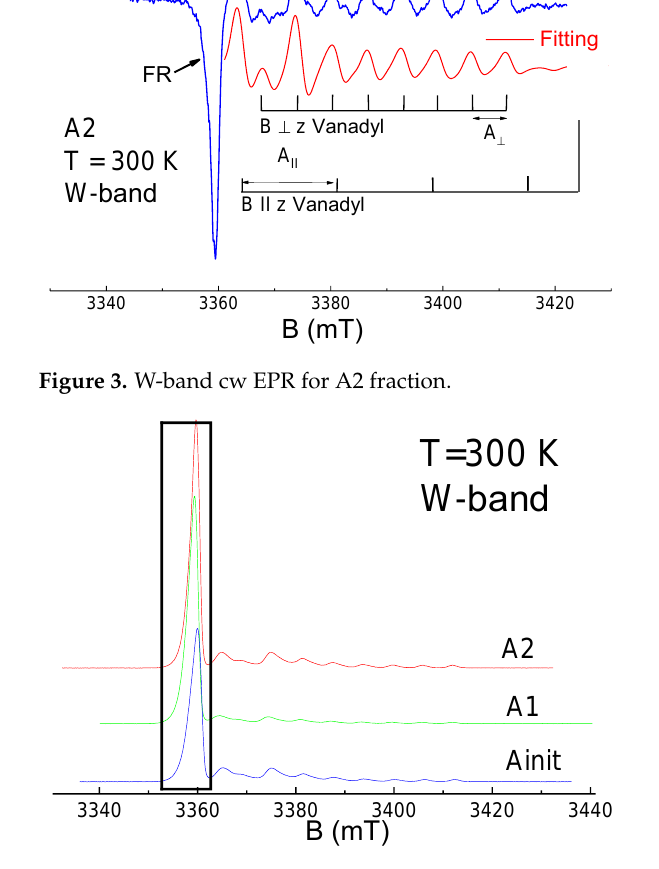
Figure 4. W-band ESE EPR for A1, A2, and Ainit fractions. Region of FR signal is marked (see Figure 5 for details).